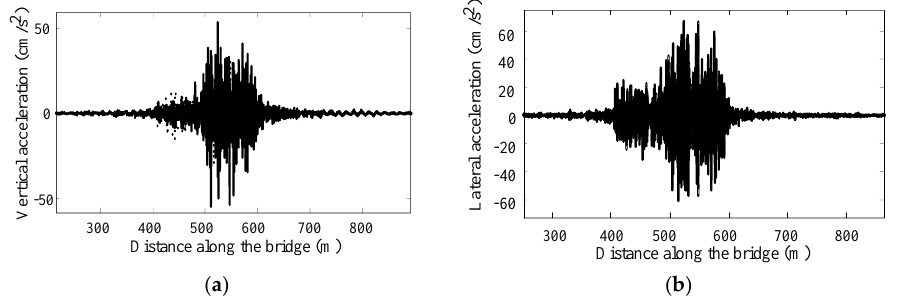
Figure 10. The time – history curves of the mid-span acceleration of the bridge under a monorail train running on a single line at a speed of 60 km/h: ( a ) the vertical direction ; ( b ) the transverse direction.